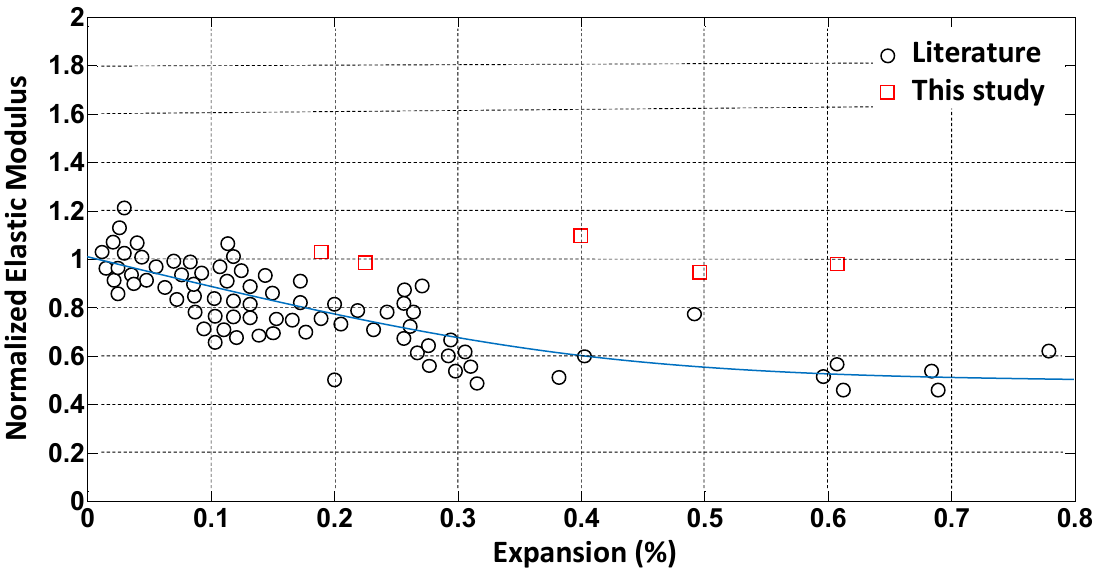
Figure 3. Normalized modulus of elasticity versus ASR expansion. Table 2. Normalized equations for estimating ASR damage as a function of expansion. Mechanical Property,